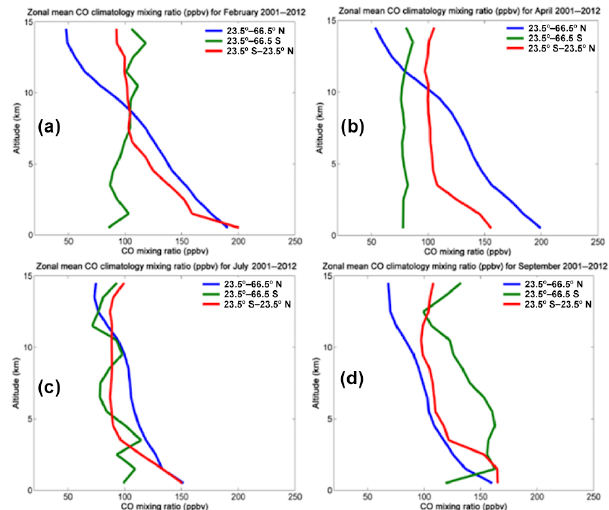
Figure 18. Monthly mean profiles of CO from the trajectory- mapped MOZAIC-IAGOS CO climatology for February, April, July, and September, averaged for 2001–2012. The different col- ors represent CO mean VMR for the latitude bands 23.5–66.5 ◦ N, 23.5–66.5 ◦ S, and 23.5 ◦ S–23.5 ◦